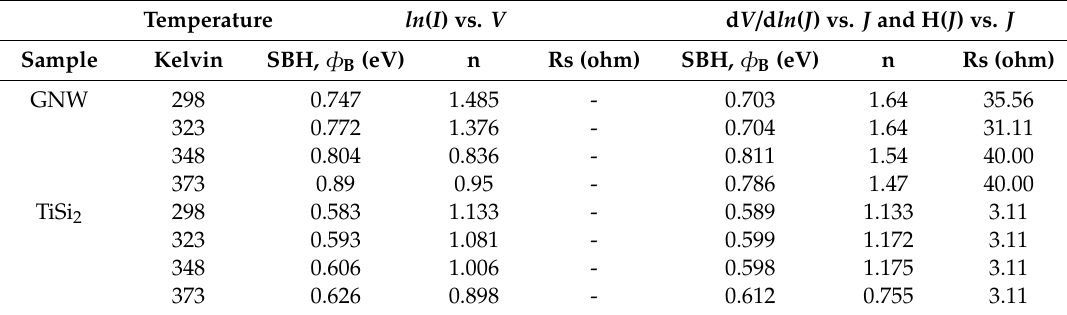
Table 1. Comparison of Schottky parameters of GNW and TiSi 2 -TMBS diodes.